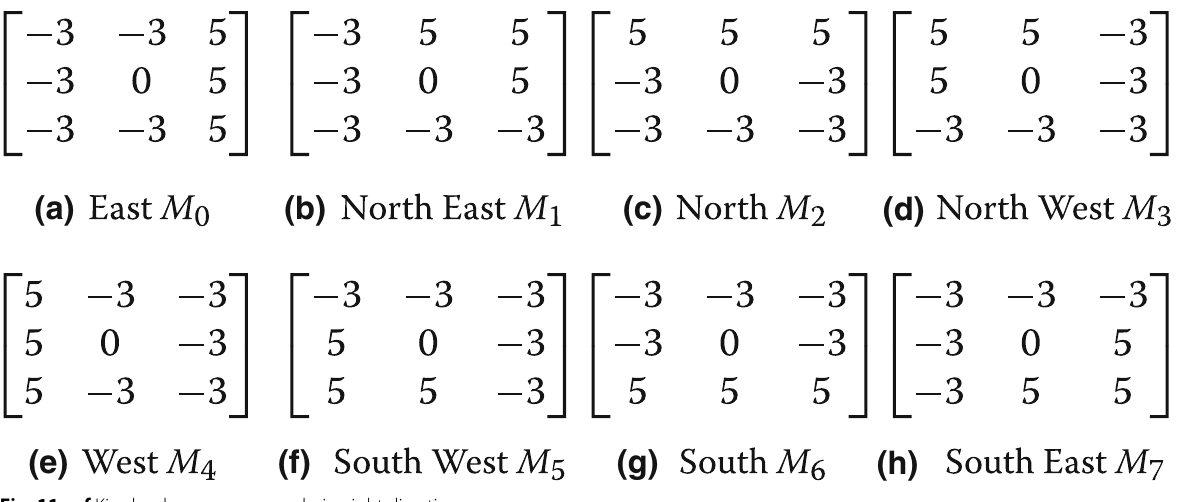
Fig. 11 a – f Kirsch edge response masks in eight directions